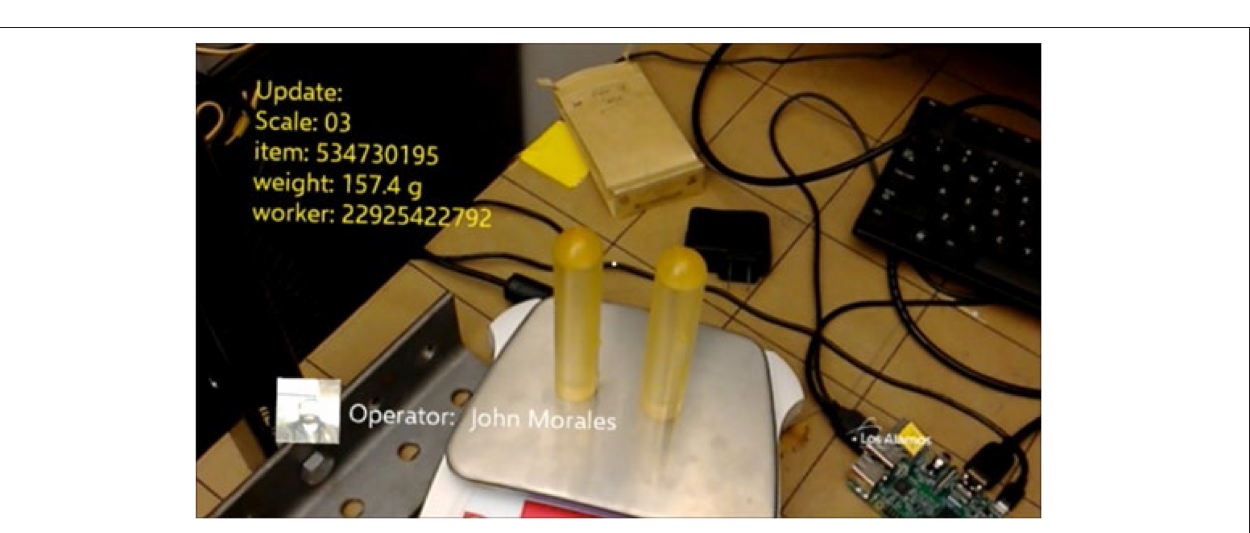
FIGURE 10 | Mock nuclear material is taken from the canister and placed on a networked balance. The measurement from the balance associated with operator and balance information is displayed in the augmented reality